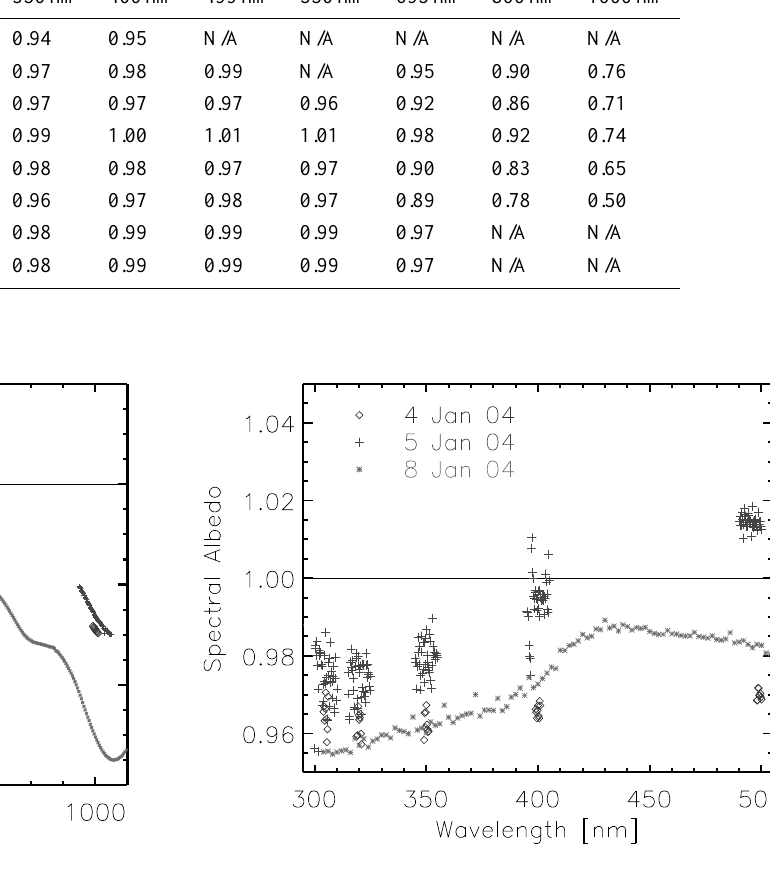
Fig. 5. Same as Fig. 4, but the wavelength range is limited (295 to 505nm). On 5 January 2004, the albedo is larger than unity with 1.015 at 500nm, which is an effect of direct incidence of solar radi-